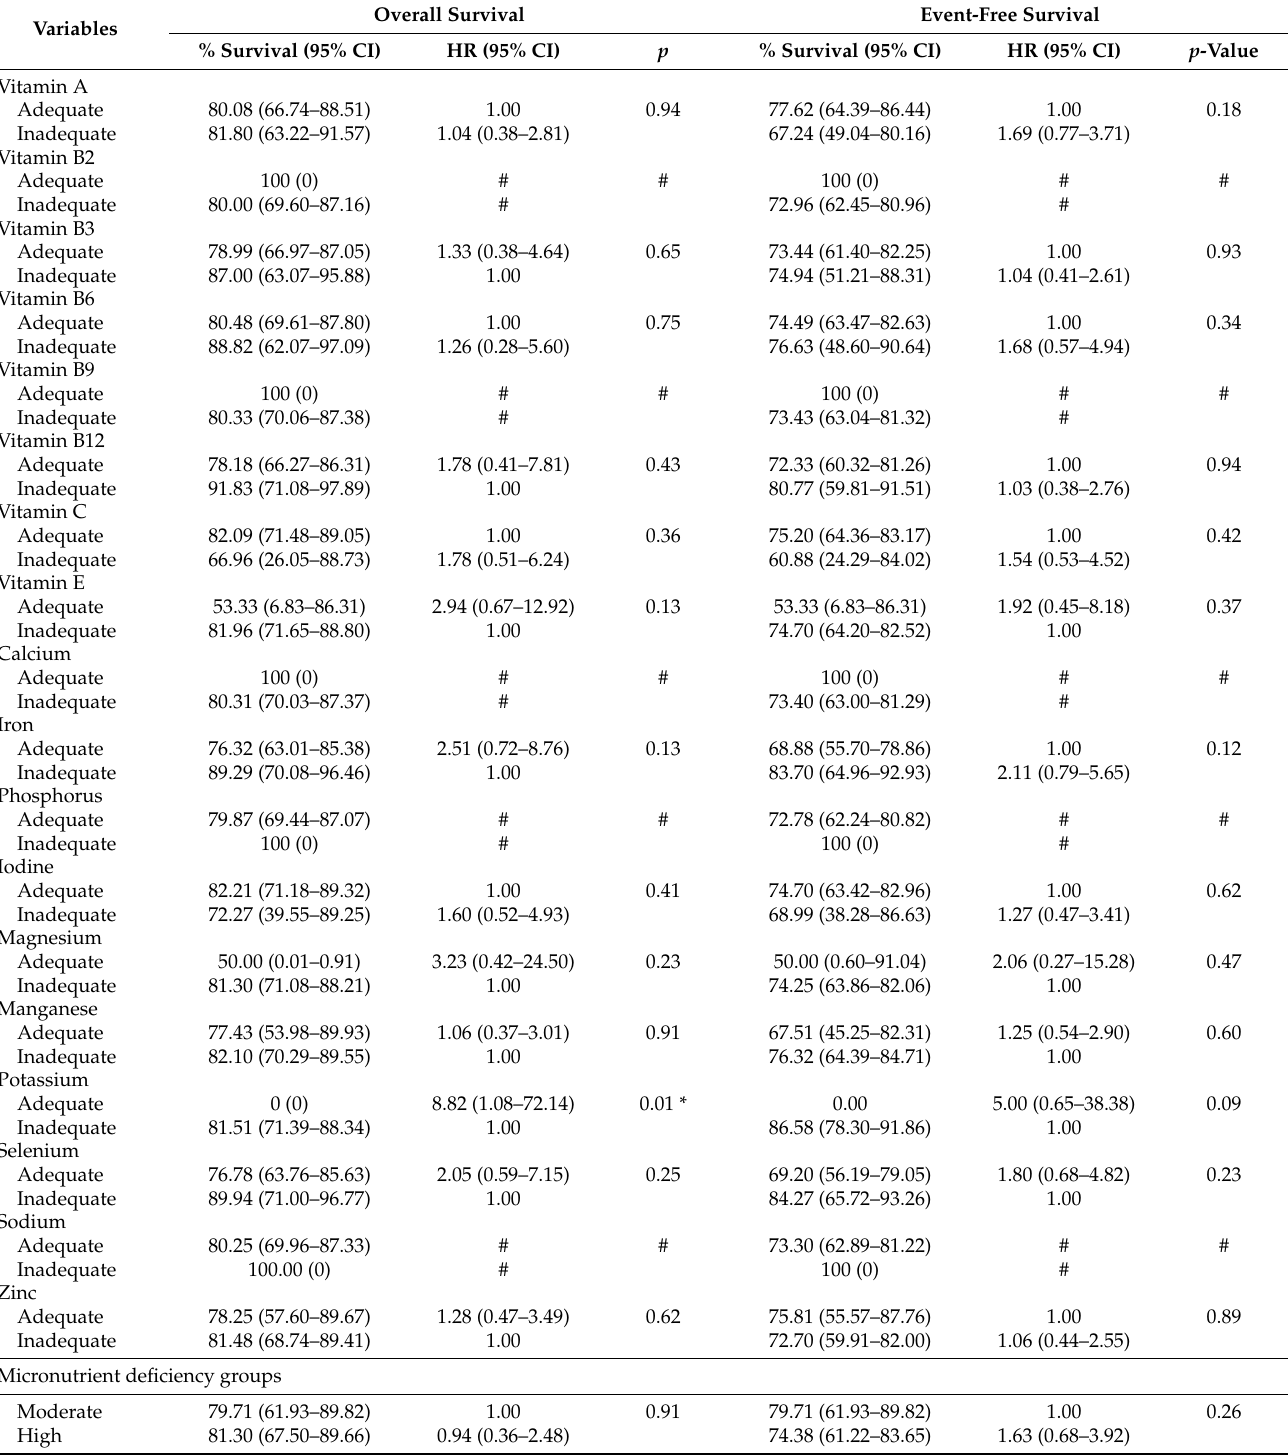
Table 3. Overall and event-free survival within 24 months in patients with HF, considering nutrient adequacy and micronutrient deficiency